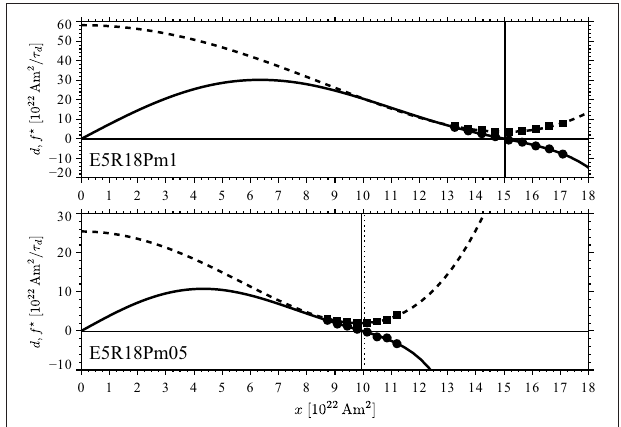
FIGURE 5 | Same as Figure 3 but for the two dynamo models at Ekman number E = 3 × 10 − 5 . The upper (lower) panel shows the case at magnetic Prandtl number Pm = 1 (Pm = 0.5 ).